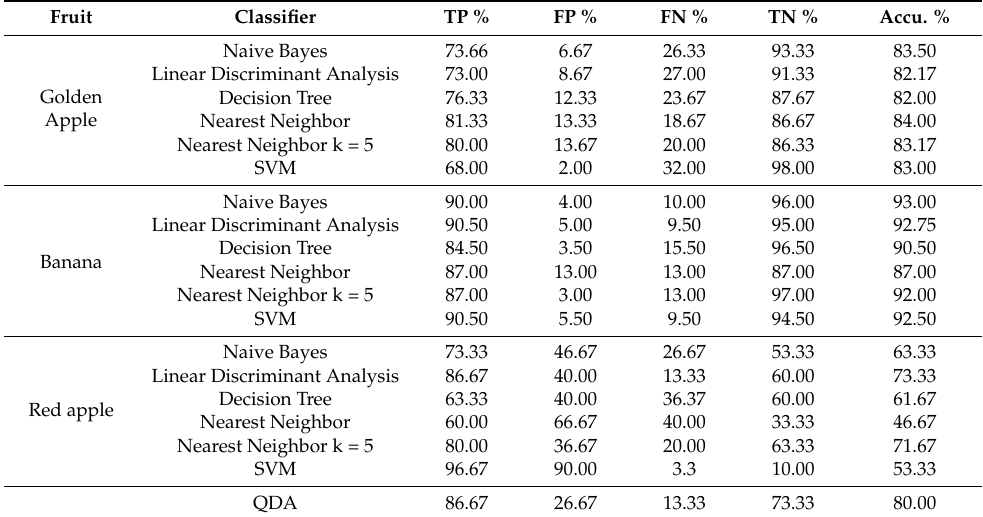
Table 4. Confusion matrix for ripeness grading identification for different